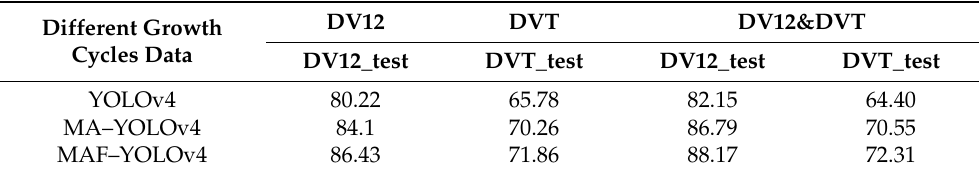
Table 3. APs of different models in different growth cycle data (unit: %); DV12&DVT, DV12, and DVT are the selected training